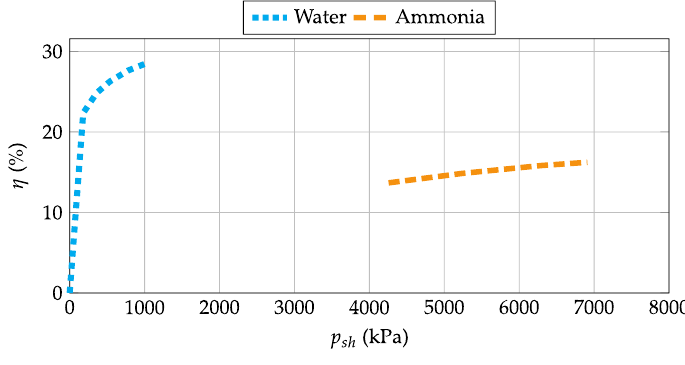
Figure 5. Performance evolution for water and ammonia considering real